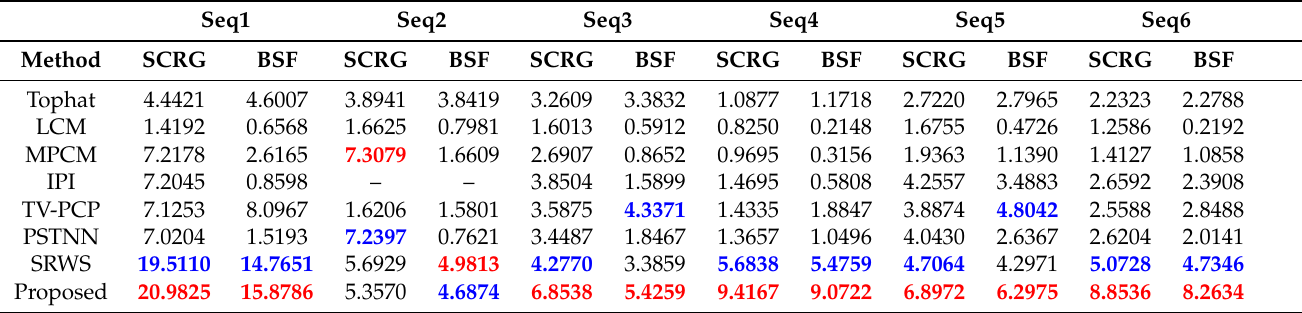
Table 2. SCRG and BSF of eight methods (bold red number: maximum value; bold blue number: second-highest value).